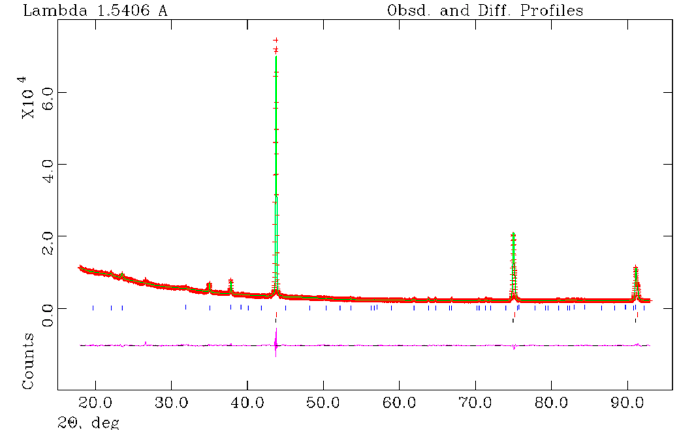
Figure 5. X-ray Rietveld refinement of the sample N2. The observed (+), calculated (solid line) and difference between observed and calculated (bottom curve) powder diffraction profiles. The positions of all allowed Bragg reflections are indicated by the rows of vertical tick marks: B 4 C upper and diamonds lower marks.